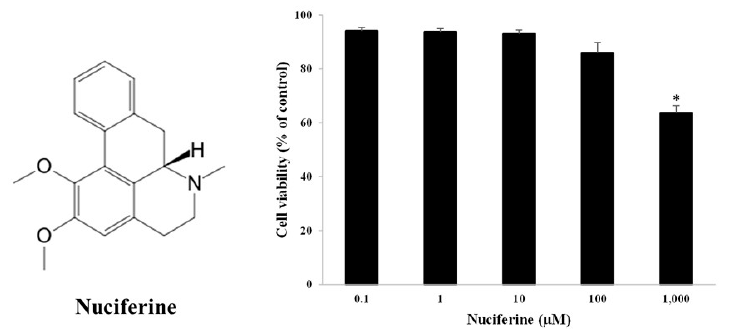
Figure 1. Structure of nuciferine (an alkaloid from lotus leaves). Fibroblast cell viability against nuciferine treatment (0–1000 µ M) (right). Percentage of viable cells expressed as mean ± SEM from triplicate independent experiments, * indicates p < 0.05 of one-way